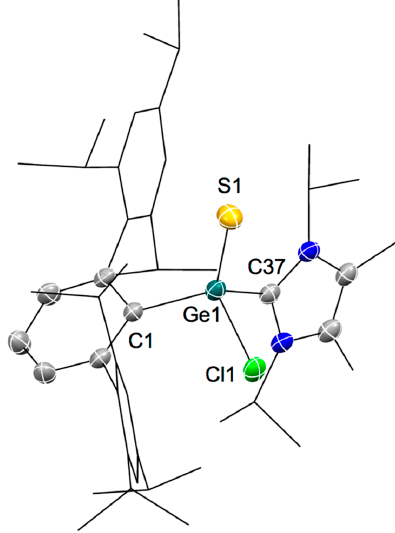
Figure 2. Molecular structure of Ge(S)Cl{C 6 H 3 -2,6-Tip 2 }(Im- i -Pr 2 Me 2 ) 3 , with thermal ellipsoids shown at the 50% probability level. Hydrogen atoms are omitted for clarity. Ge: Green, S: Yellow, Cl: Light green, N: Blue, C: gray. Selected bond distances (Å) and angles ( ˚ ): Ge1–S1 2.0846(8), Ge1–Cl1